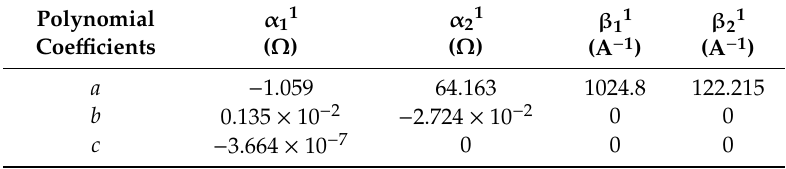
Table 15. Nonlinear parameters for MT6 pi-circuit as a function of soil